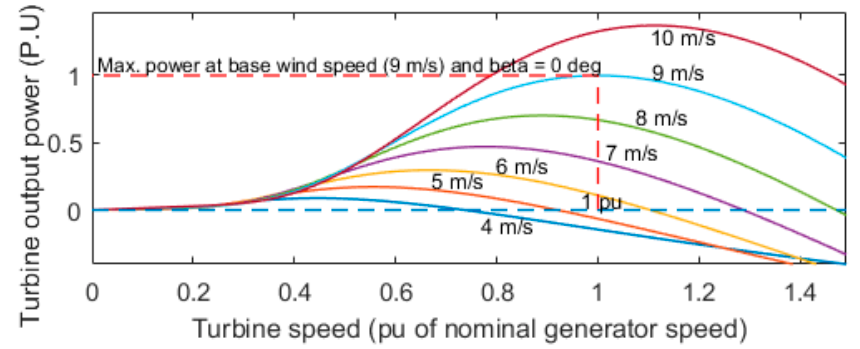
Figure 1. Turbine power characteristics (pitch angle beta = 0 deg).